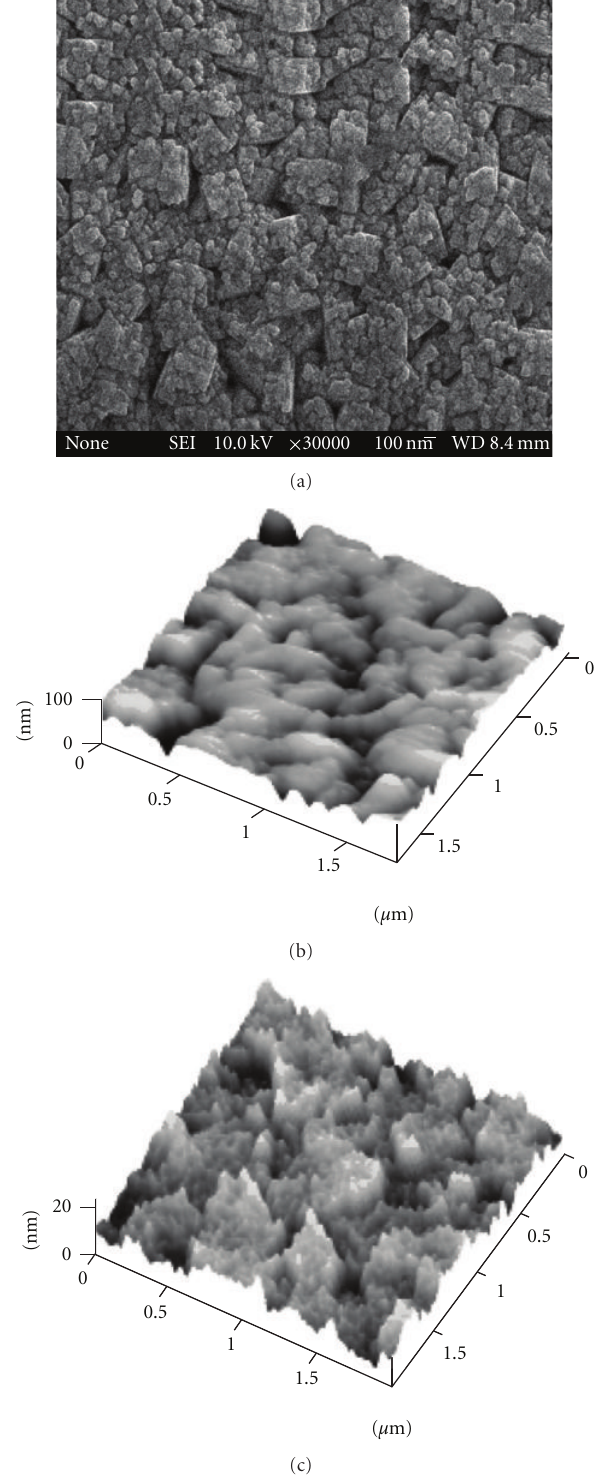
Figure 3: (a) Scanning electron microscope (SEM) image of IZO film prepared by ultrasonic spray pyrolysis. The topography of (b) IZO-coated glass and (c) ITO-coated glass substrates measured using atomic force microscopy (AFM). The root mean square surface roughness is 12.37 nm for IZO and 2.41 nm for